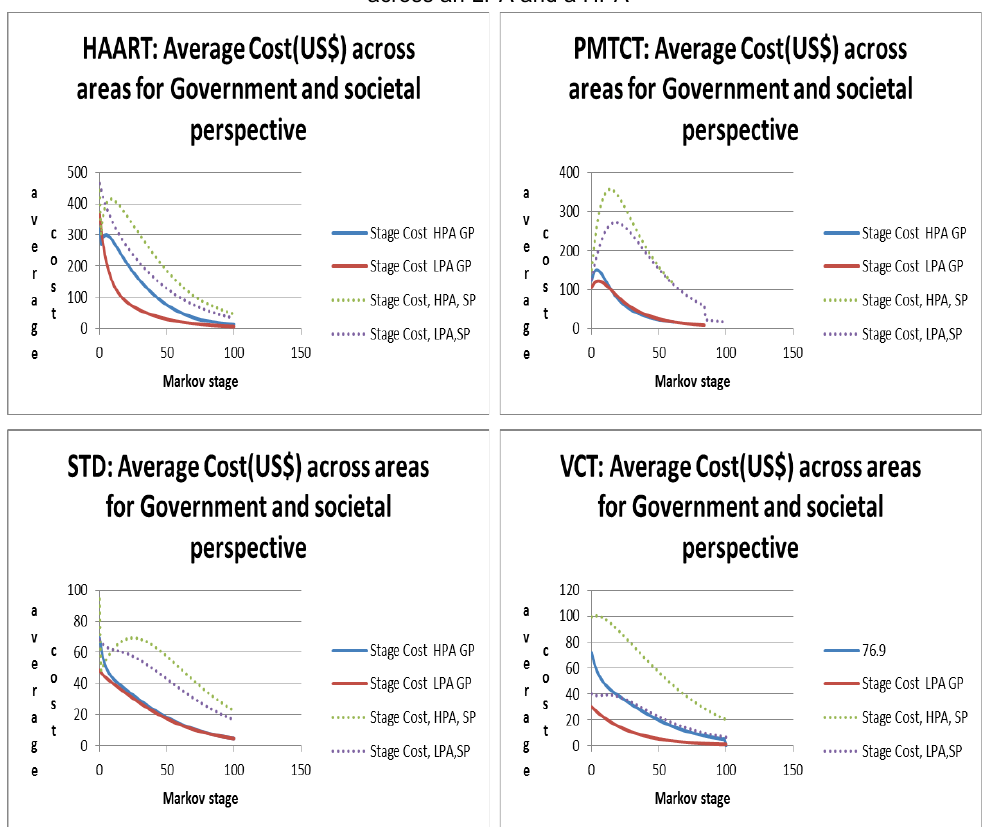
The average costs in health states (government and societal perspective) comparisons across an LPA and a